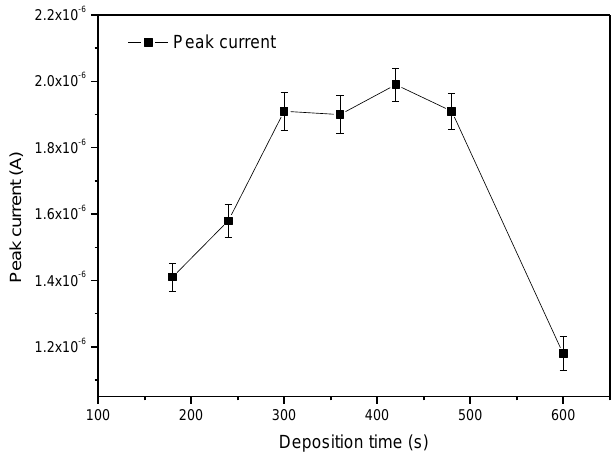
Figure 7. Effect of deposition time on the peak current response. The data for respective error bar were obtained from four separate